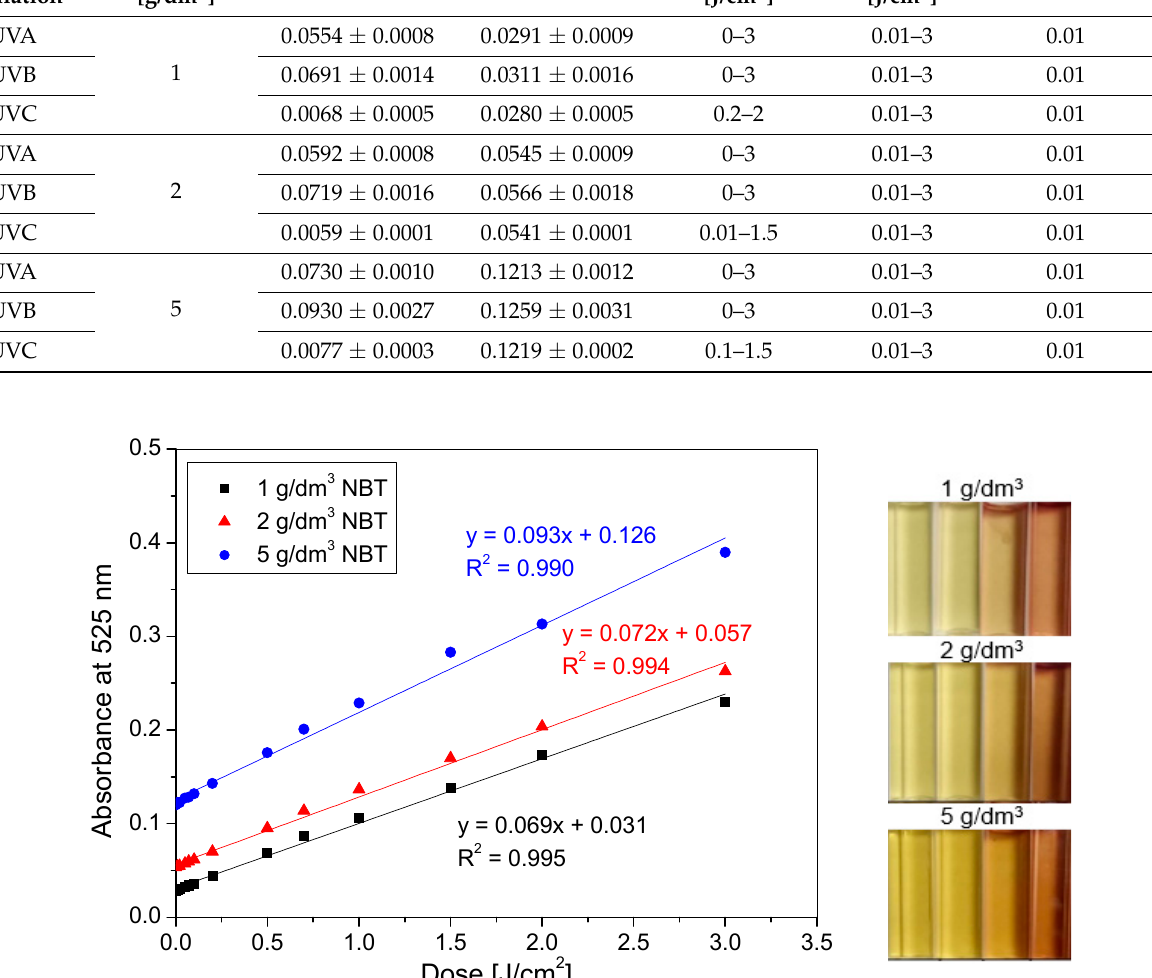
Figure 4. The dose responses of NBT-Pluronic F-127 hydrogels containing 1, 2 and 5 g/dm 3 NBT irradiated with UVB radiation in the dose range of 0–3 J/cm 2 with corresponding photographs illustrating the samples’ colour changes after irradiation with doses 0, 0.07, 0.7 and 3 J/cm 2 (from left to right ). Table 1. Basic characteristics of NBT-Pluronic F-127 gels with various concentrations of NBT and irradiated with UVA, UVB and UVC radiation.